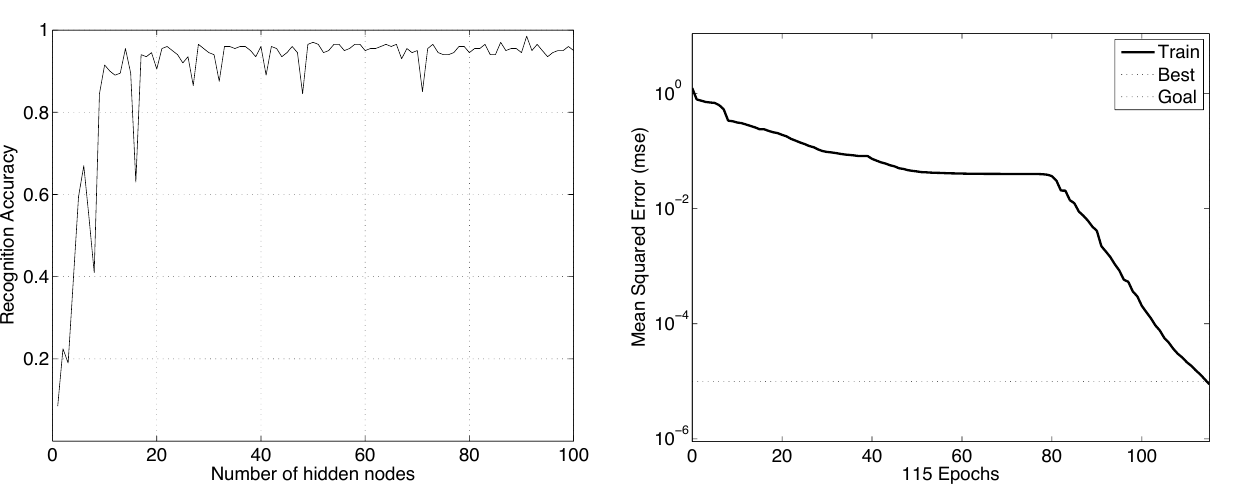
Figure 13. Results of deciding the number of hidden nodes ( left ) and the epoch and goal ( right ) for stepping pattern-based